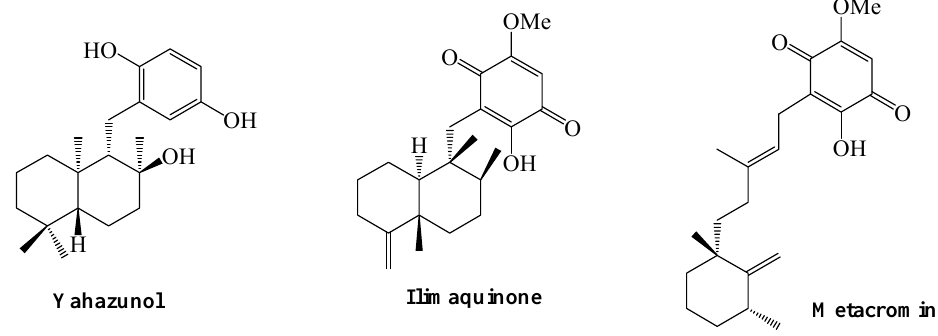
Figure 1. Some examples of natural